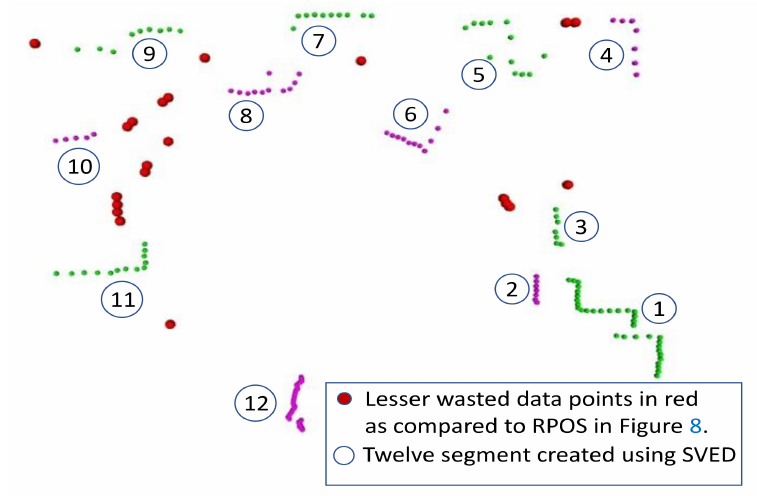
Figure 9. The segmentation using varying Euclidean-distance-based cluster extraction (SVED) ap- proach with red marks representing lesser wasted datapoints, which are not part of any segment in the scan. The green and purple colors are used to show the data points of two consecutive